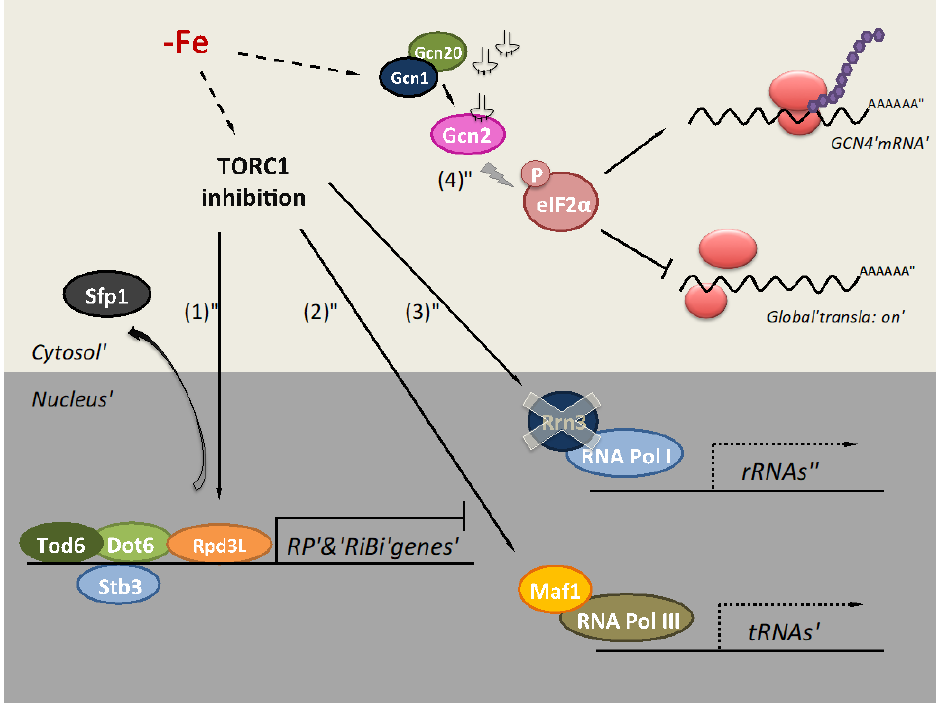
Figure 1. Mechanisms of regulation of protein synthesis in response to iron deficiency in the budding yeast S. cerevisiae at different levels. Upon iron depletion, TORC1 complex is inactivated, leading to (1) repression of RP and RiBi genes transcription by Tod6, Dot6, Stb3, and Rpd3L complex, and export of their transcriptional activator Sfp1 to the cytosol; (2) inhibition of RNA Pol III by association to its dephosphorylated Maf1 repressor; and (3) inhibition of RNA Pol I activity due to the decrease in the levels of its Rnr3 activator [12]. Moreover, (4) phosphorylation of eIF2 α by Gcn2 inhibits global protein synthesis at the initiation stage in a Gcn1-Gcn20-dependent manner and promotes GCN4 mRNA translation [36].